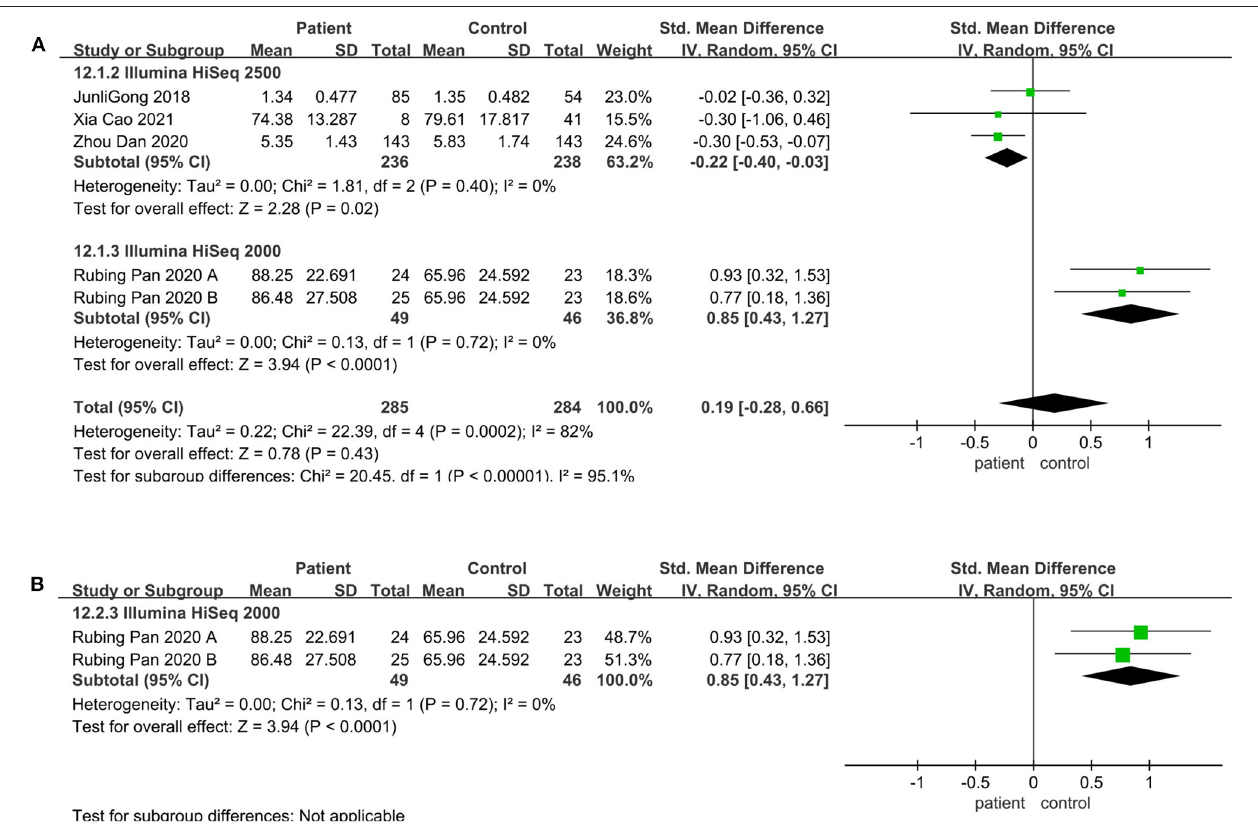
FIGURE 4 | Richness meta-analyses for the sequencing instrument. Forest plot for the observed species (A) and Chao1 (B) . SMD, standardized mean difference; SD, standard